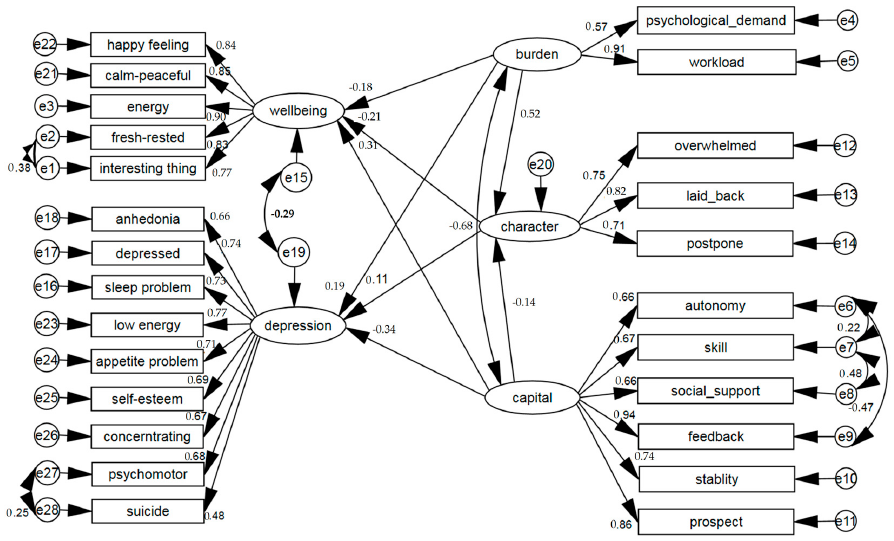
Figure 1. Structural equation model of Job Burden-Capital-Depression-Wellbeing.